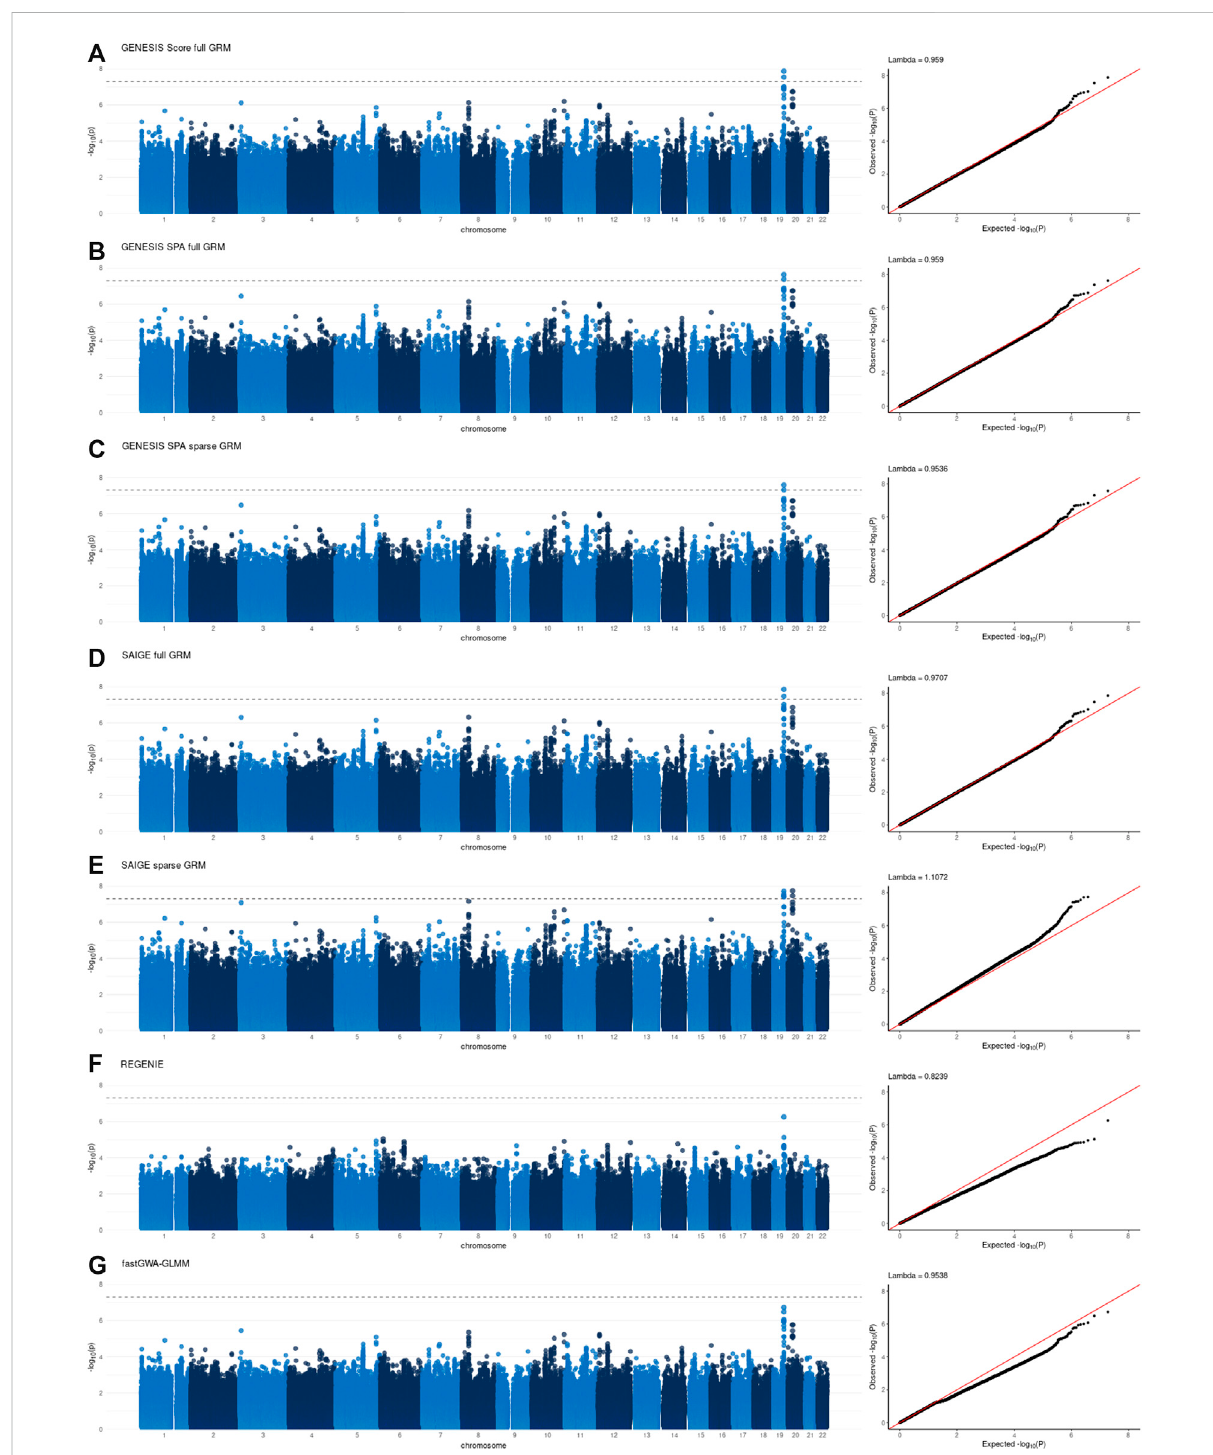
FIGURE 2 Manhattan and QQ plots of -log10( p -values) for the associations using WGS data in the Long Life Family Study (LLFS) data. Panel (A) : associations based on the score test and adjusted for the full genetic relation matrix (GRM) using GENESIS. Panel (B) : associations based on the SPA and adjusted for the full GRM using GENESIS. Panel (C) : associations based on the SPA and adjusted for the sparse GRM using GENESIS. Panel (D) : associations based on the SPA and adjusted for the full GRM using SAIGE. Panel (E) : associations based on the SPA and adjusted for the sparse GRM using SAIGE. Panel (F) : associations based on the SPA and polygenic effect estimates to control for relatedness using REGENIE. Panel (G) : associations based on the SPA and adjusted for the sparse GRM using fastGWA-GLMM. Lambda is a genomic in fl ation